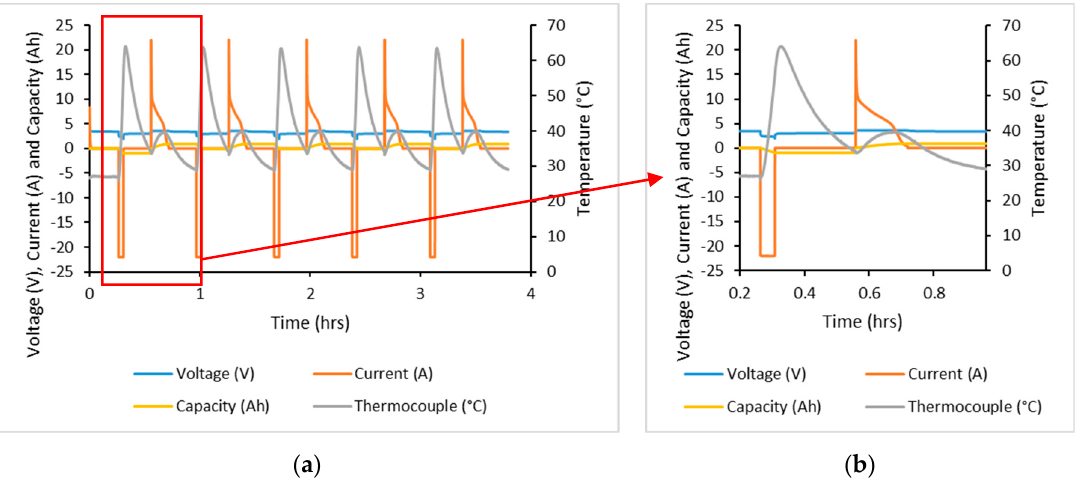
Figure 3. Typical cell test data for high rate cycling test. ( a ) shows typical cell test data, ( b ) a closer view of cell test data.